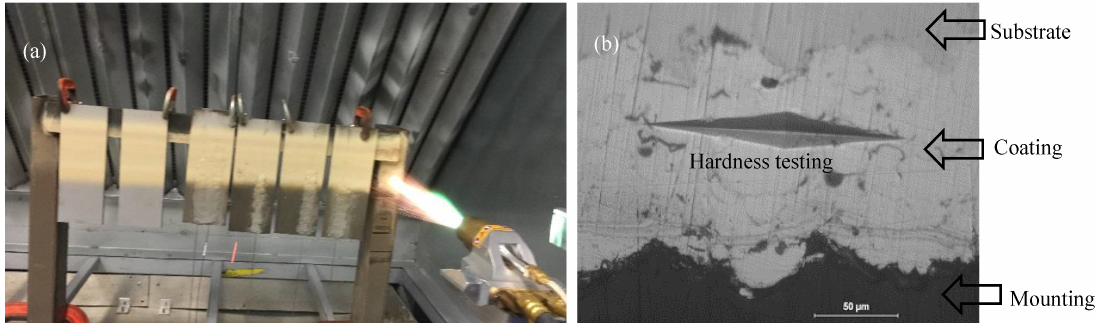
Figure 9. ( a ) HVOF thermal spray coating application and ( b ) SEM image of the coating.